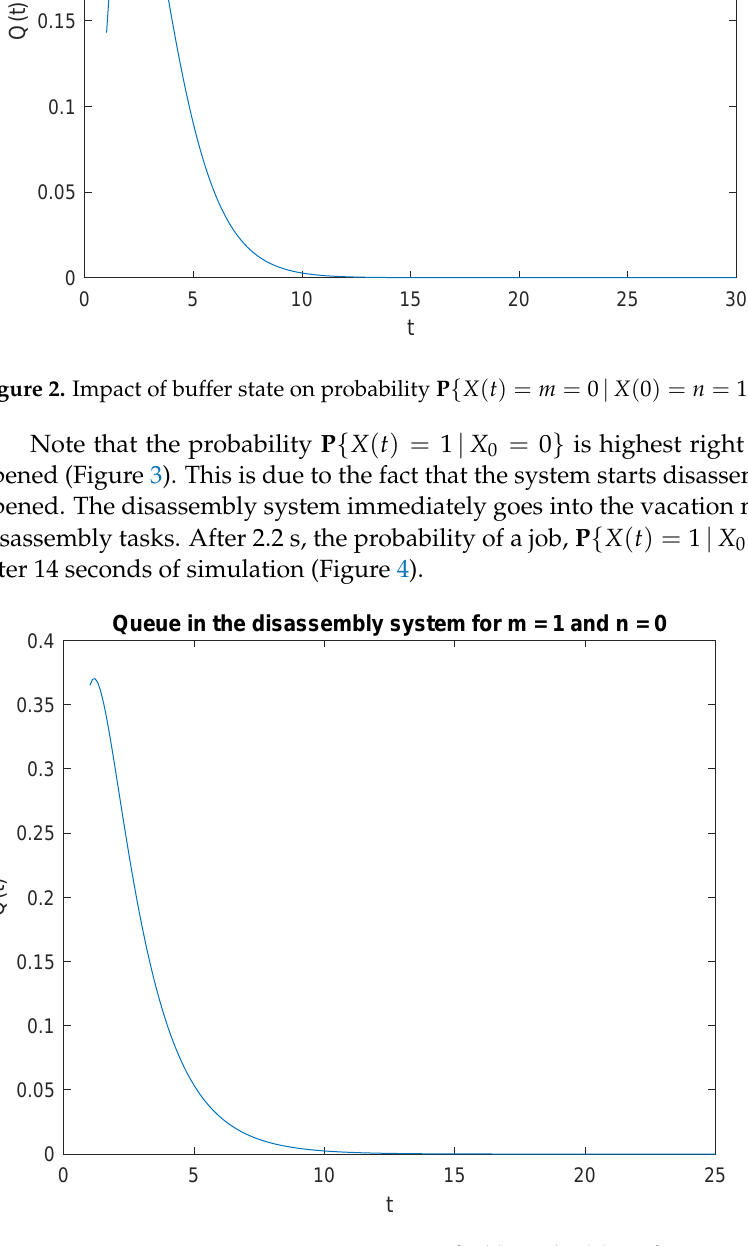
Figure 3. Impact of buffer state on probability P { X ( t ) = 1 | X ( 0 ) = 0 }